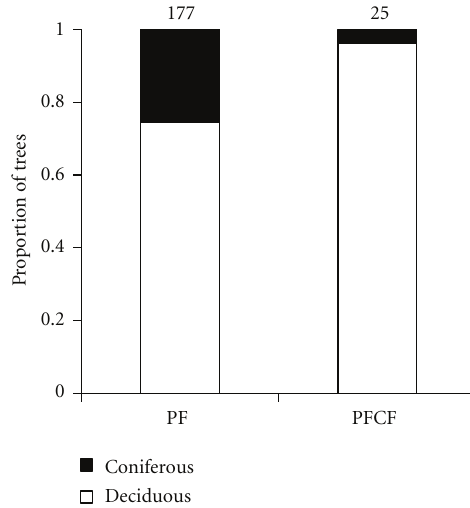
Figure 3: Proportion of coniferous versus deciduous tree species in the breeding territories of pied flycatcher pairs (PF) compared to the breeding territories of male pied flycatchers paired to a female collared flycatcher (PFCF) on the Swedish island of ¨Oland, 2002– 2010. Male pied flycatchers have a lower risk of hybridizing in habitats with coniferous forest. Sample sizes are given above the